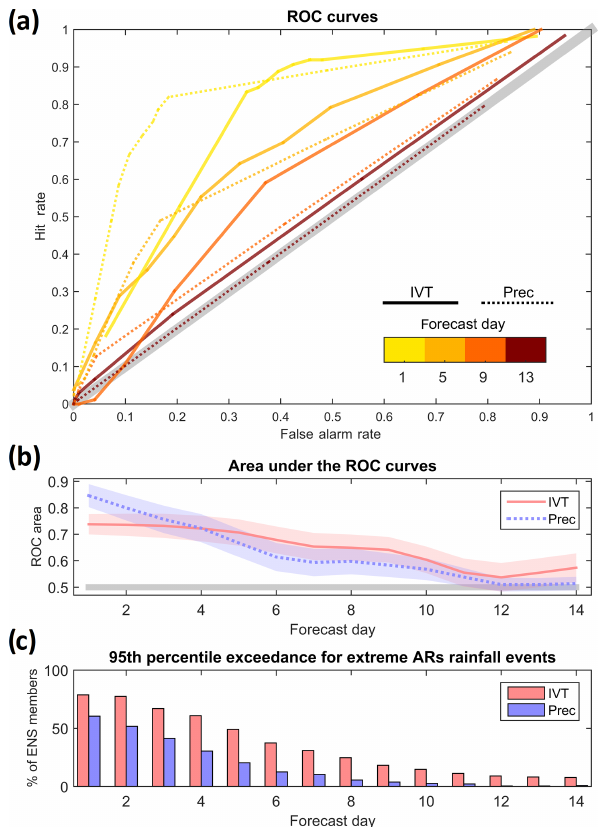
Figure 1. Receiver operating characteristic (ROC) curves for the IVT and precipitation ensemble forecasts during atmospheric river (AR) days from the ECMWF model are shown using Por- tuguese surface meteorological stations during the extended winters (October–March) of 2012–2016 as a benchmark, and considering events above the 95th percentile (a) . The solid lines are for the IVT and dashed lines for precipitation. Different curve colors represent different lead times for the forecasts (1, 5, 9, and 13d). Area under the ROC curves are shown for lead times up to 14d (b) , where the confidence intervals are also shown. The mean percentage of en- semble members forecasting IVT (pink) and precipitation (purple) above the 95th percentile for lead times up to 14d during extreme rainfall events associated with ARs (observed precipitation above the 95th percentile associated with an AR over western Iberia) is shown in (c) .